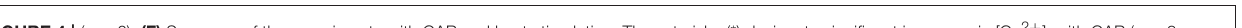
FIGURE 4 | ( n = 6). (F) Summary of the experiments with CAP and heat stimulation. The asterisks (*) designate significant increases in [Ca 2 + ] i with CAP ( n = 8; p < 0.05 at the minimum; paired tested). The hashtags (#) indicate statistically significant differences in fluorescence ratios between CAP with and without CPZ ( n = 6–8; p < 0.01 at the minimum; non-paired tested). (G) CAP (10 µ M) induced a reversible increase in Ca 2 + influx ( n = 9) whereas non-treated control cells maintained a constant Ca 2 + baseline ( n = 10). (H) Same experiment as shown in (G) , but in the presence of capsazepine (CPZ). CPZ (10 µ M) suppressed the CAP-induced Ca 2 + increase ( n = 12). (I) Summary of the experiments with CAP and CPZ. The asterisks (*) designate significant increases in [Ca 2 + ] i with CAP ( n = 9; p < 0.05; paired tested). The hashtag (#) denotes a statistically significant difference in fluorescence ratios between CAP with and without CPZ ( n = 9–12; p < 0.05; non-paired